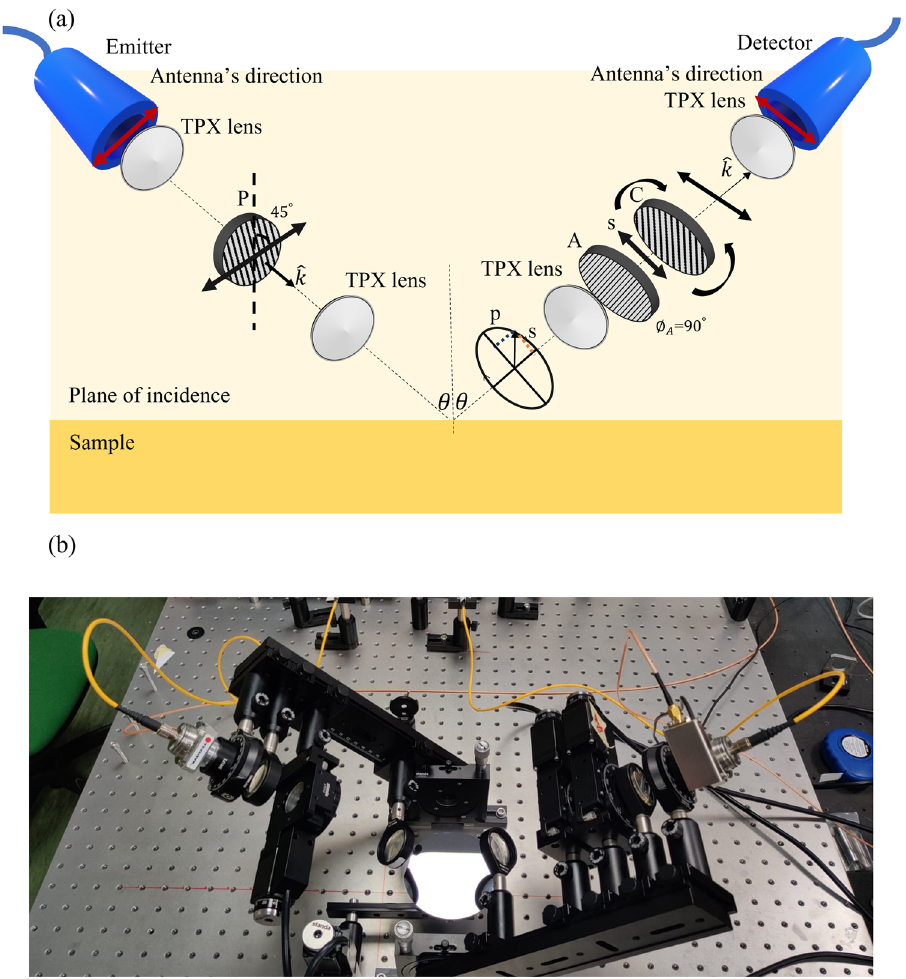
Figure 1. ( a ) Opto-mechanical setup sketch and ( b ) picture of the realised fiber-coupled THz-TDSE. In ( a ) P , A , C stand for the role played by each wire grid polarizer, and the scheme for the detection of the s-polarised component ( φ A = 90 ◦ ) is shown.